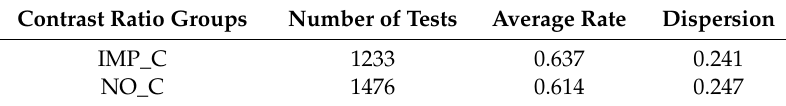
Table A6. Numerical results of the users regarding the contrast ratio groups. Contrast Ratio Groups